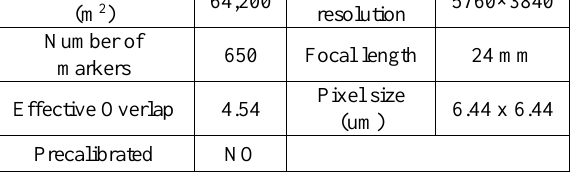
Table 1. Processing Summary